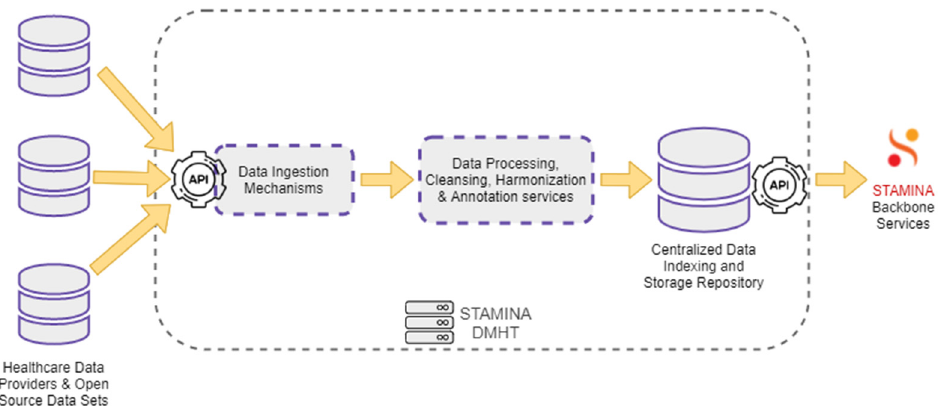
Figure 6. Data Management and Harmonization Tool: Data Flow.